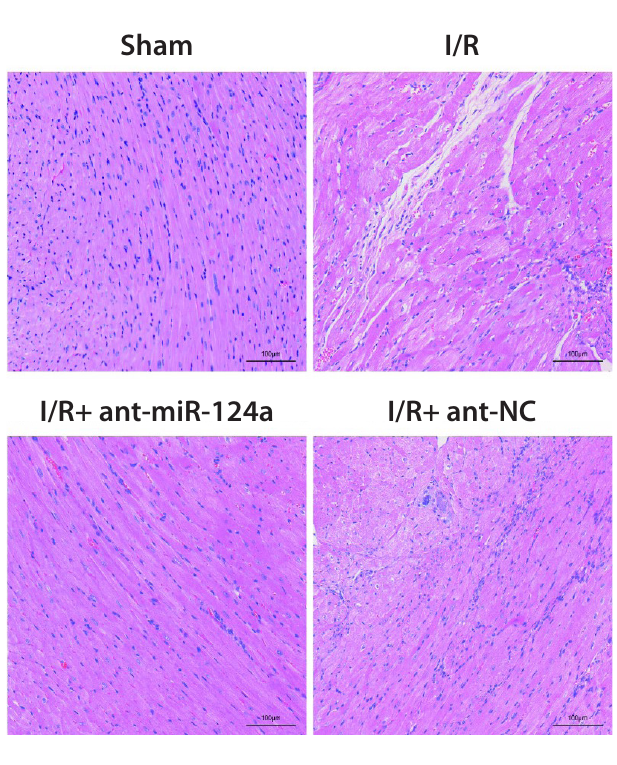
Fig. 1 - The effect of micro ribonucleic acid (miR)-124a on hematoxylin staining of myocardial tissue after myocardial ischemia reperfusion (I/R) in rats. ant=antagomir; NC=normal